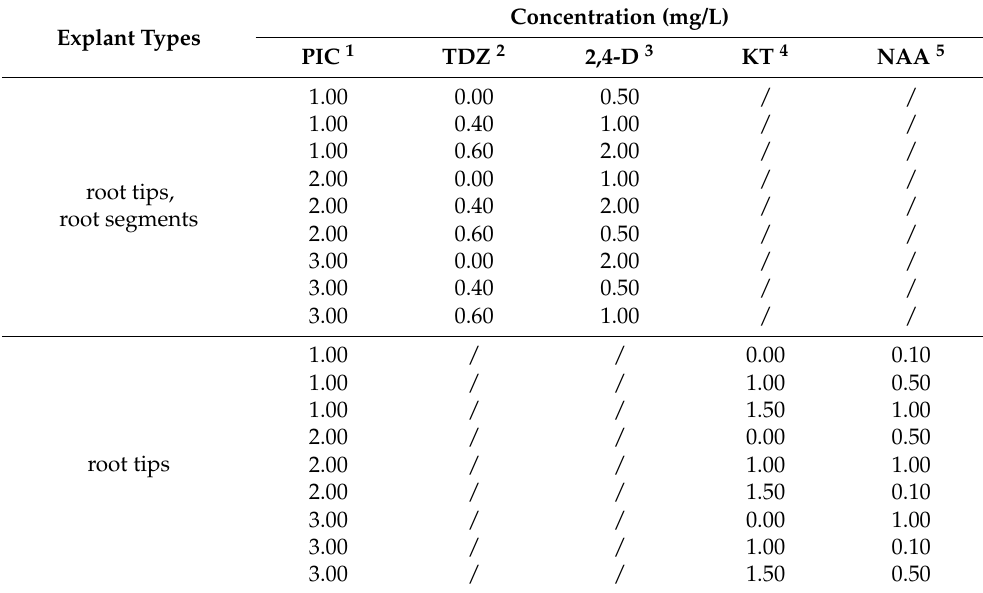
Table 1. CIM design for callus induction from root explants of A. praecox